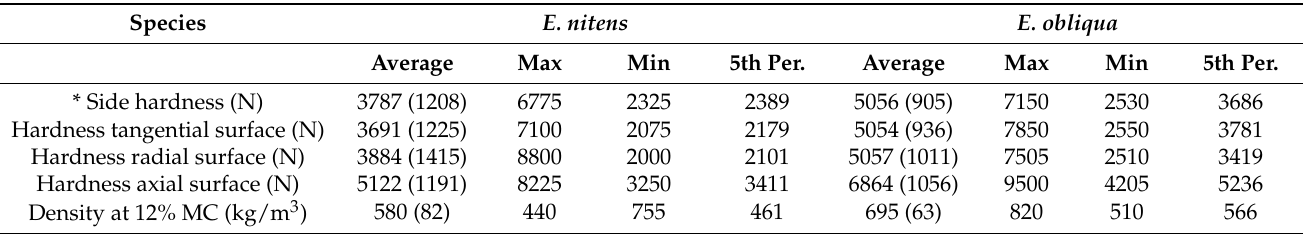
Table 2. Janka hardness and density of sawlog E. nitens and regrowth forest E. obliqua